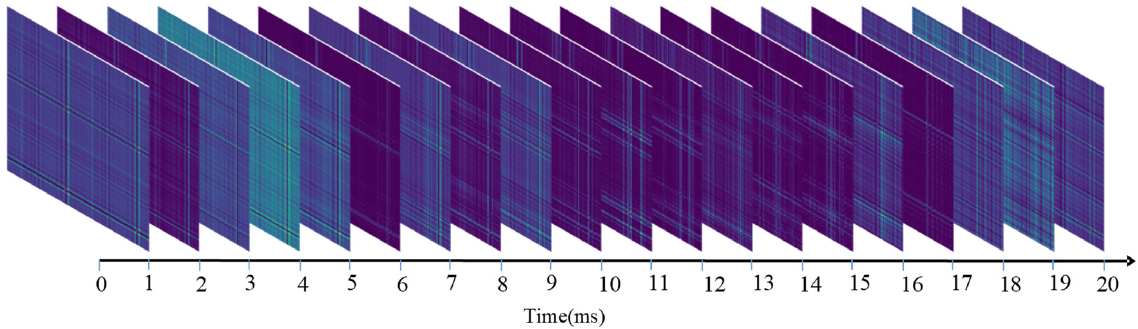
Figure 4. Sequential sEMG-GAF images obtained from the CagpMyo DB-a dataset; 144-channel sEMG signals were sampled at 1000 frames/second.